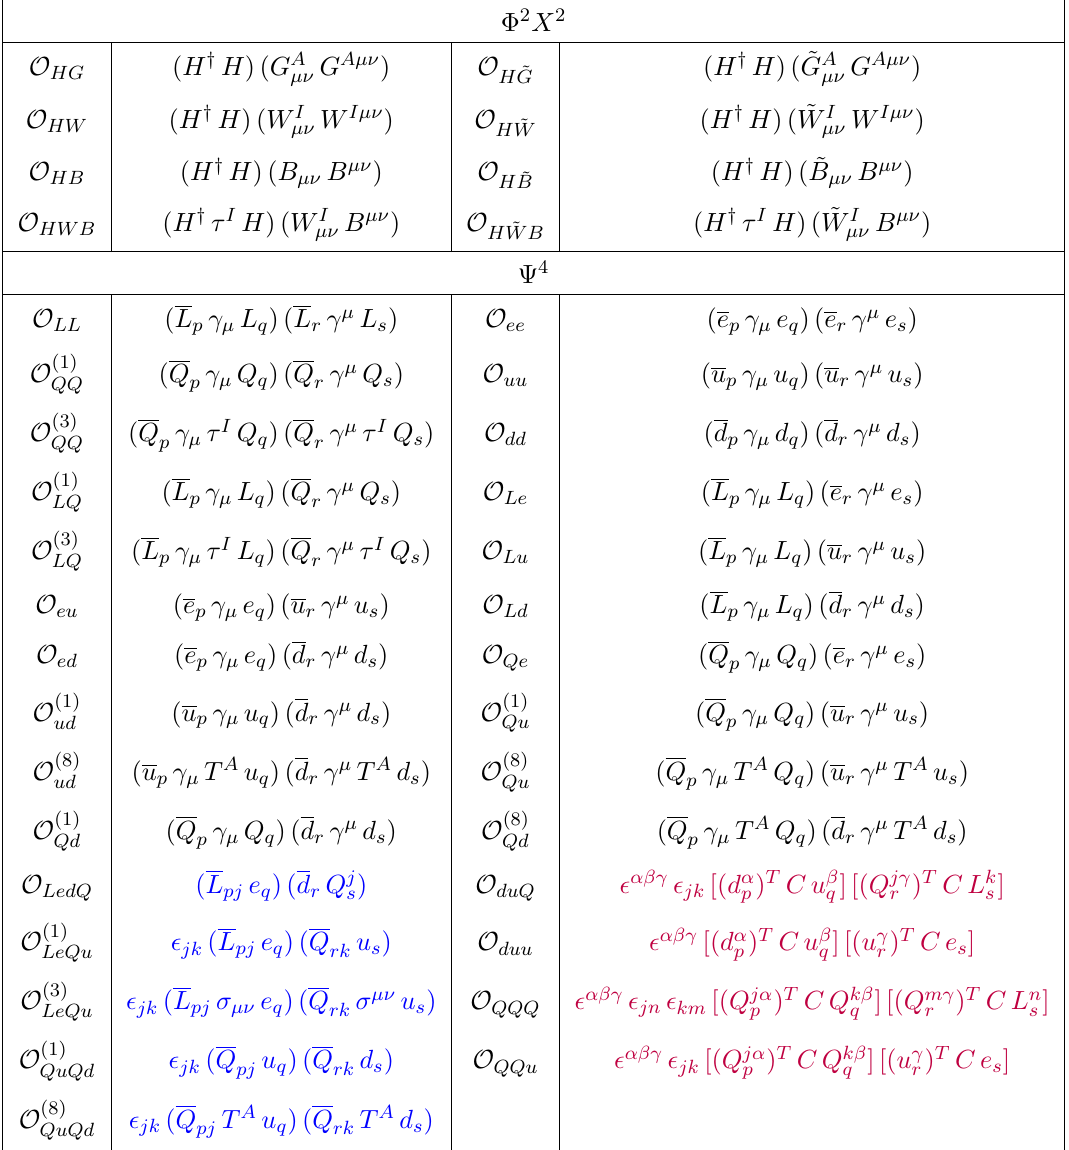
Table 31 . Table 30 continued. Here j, k, m, n and α, β, γ are the SU(2) and SU(3) indices re- spectively and p, q, r, s = 1 , 2 , · · · , N f are the flavour indices. Operators in red violate lepton and baryon numbers.